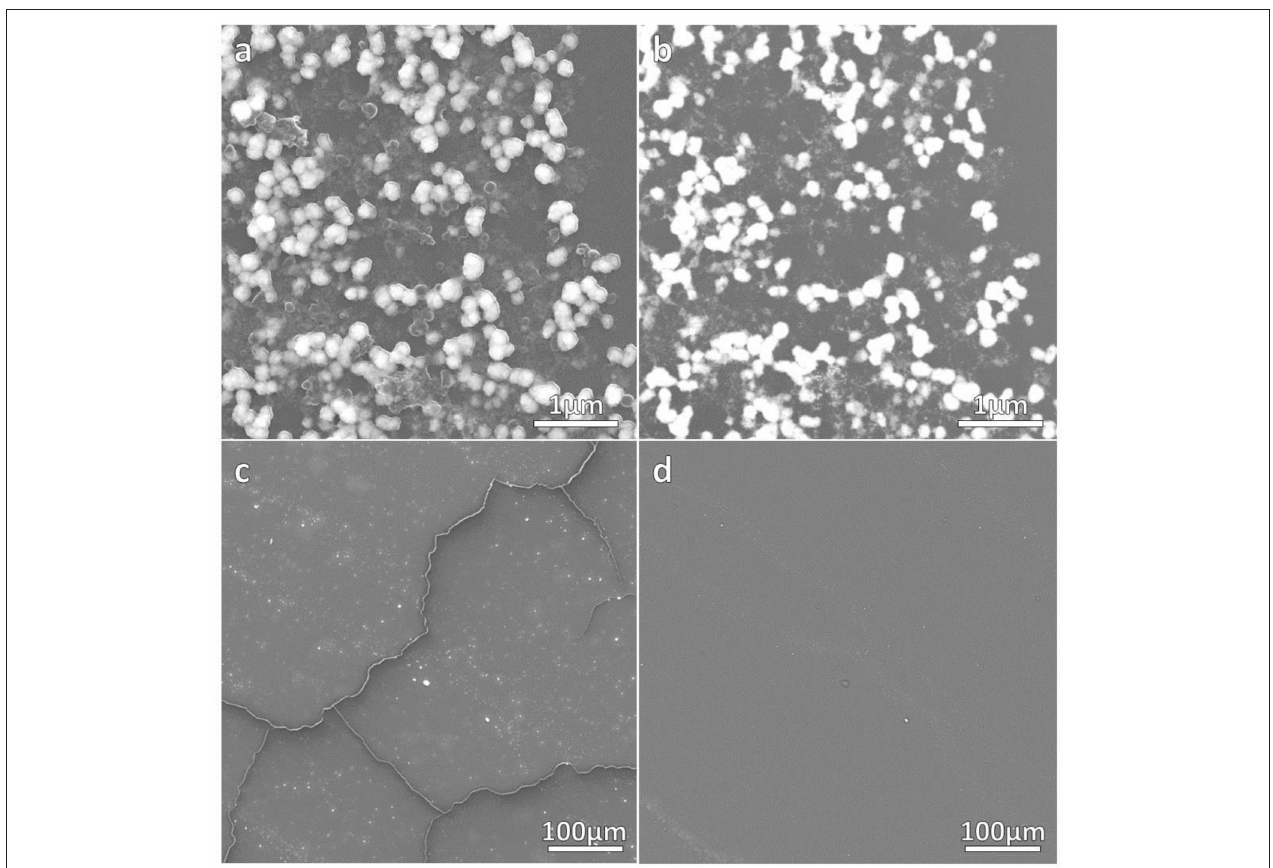
FIGURE 3 | SEM micrographs of PNA_1 sample. (a,c) contain topographical micrographs recorded with secondary electrons, while (b,d) contain Z-sensitive micrographs recorded with backscattered electrons.